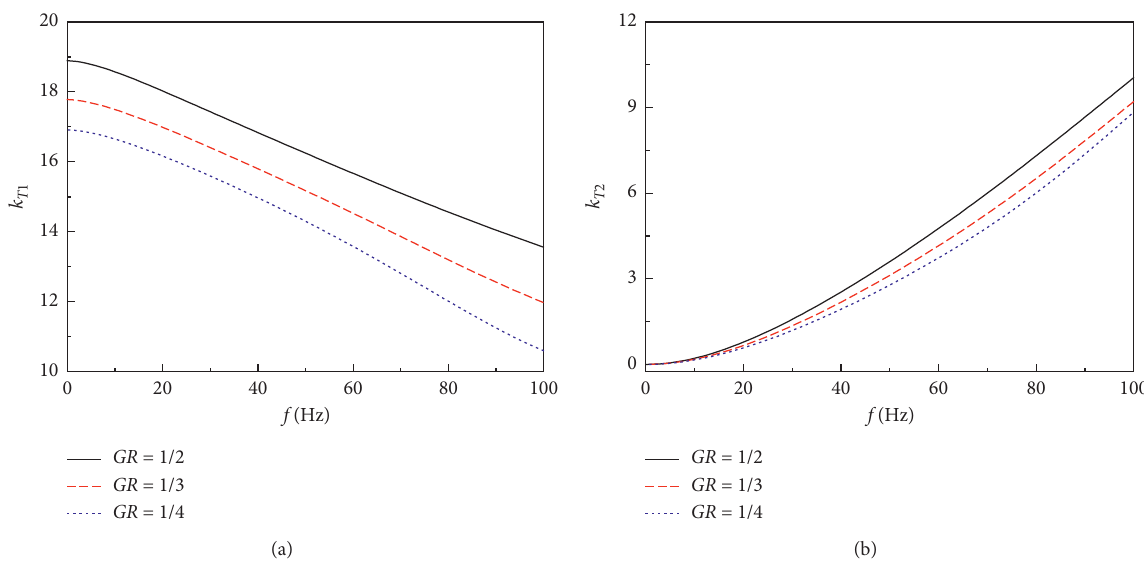
Figure 5: Influence of the shear modulus ratio GR � G ( D sm � D s 0 � 0, t m / r 0 � 0.25).